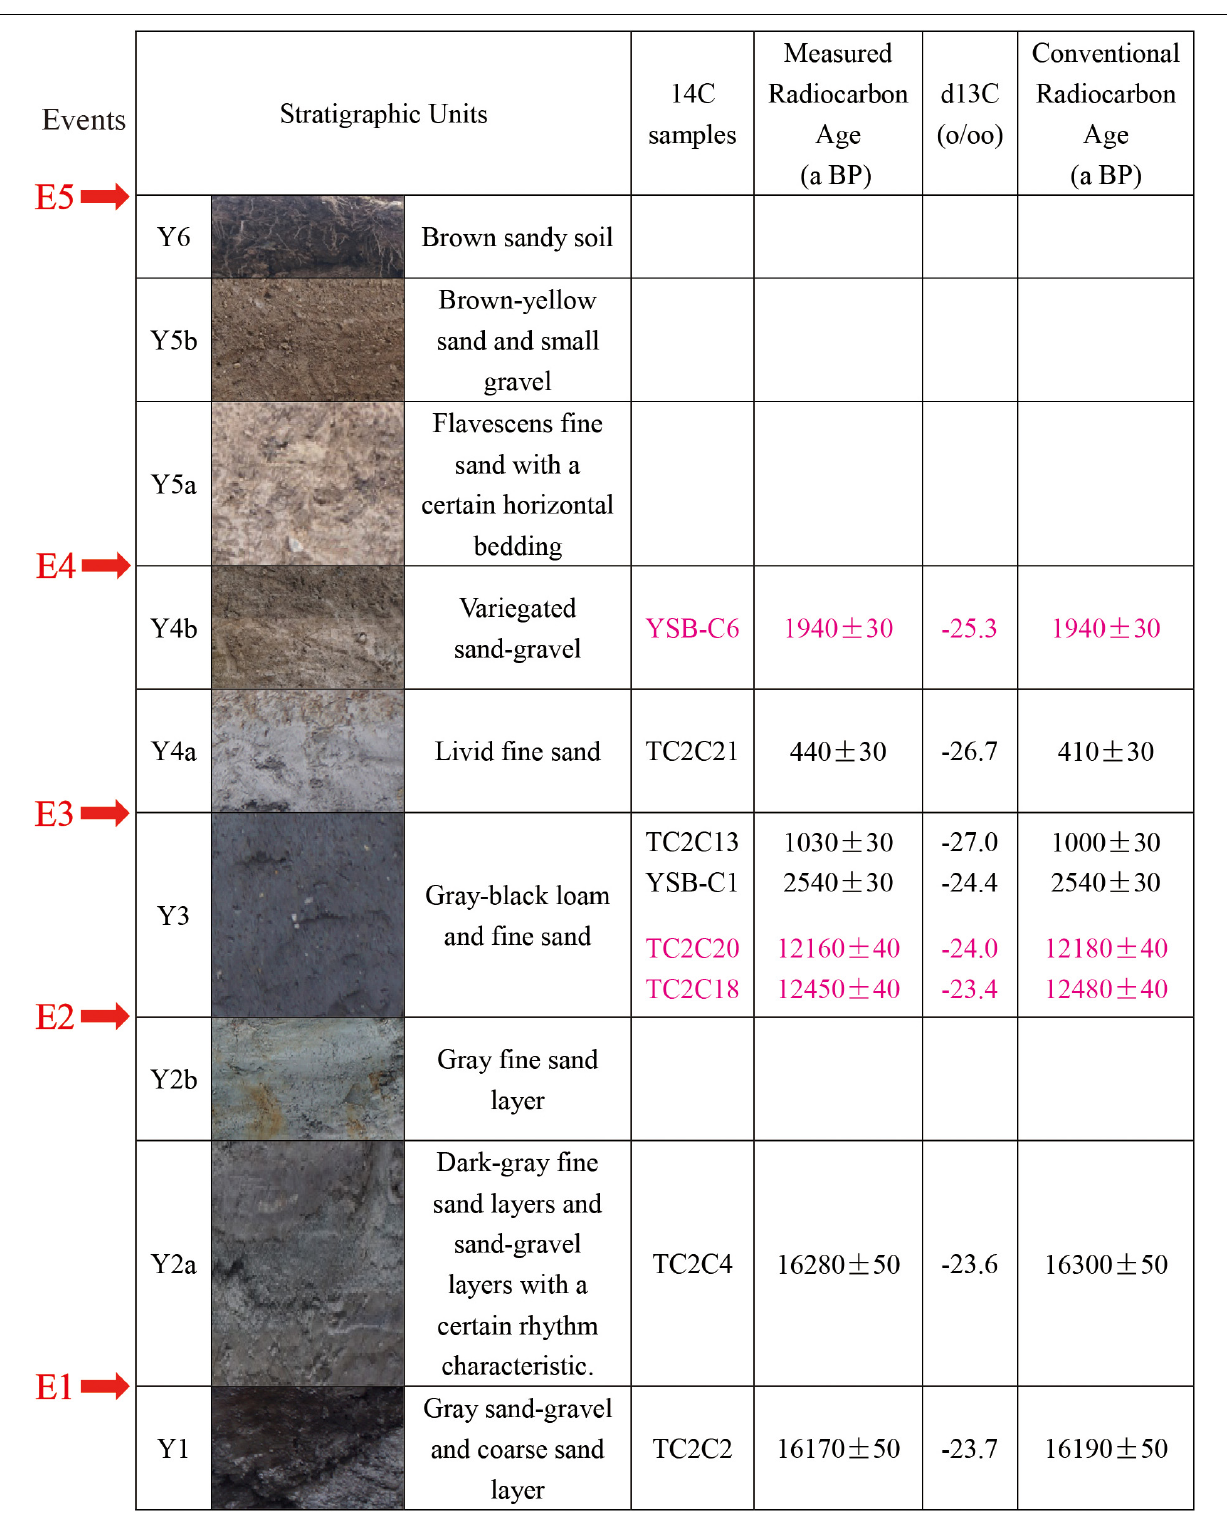
FIGURE 7 | Stratigraphic sequence and radiocarbon dates of TC1. The samples labeled in purple text are considered markedly older than the depositional units in which they occur. All samples were processed at Beta Analytic Inc., Miami, FL, United States.